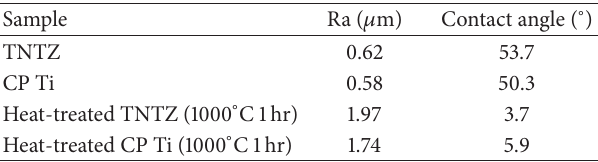
Table 1: Average roughness (Ra) and wettability of TNTZ and CP Ti before and after heat